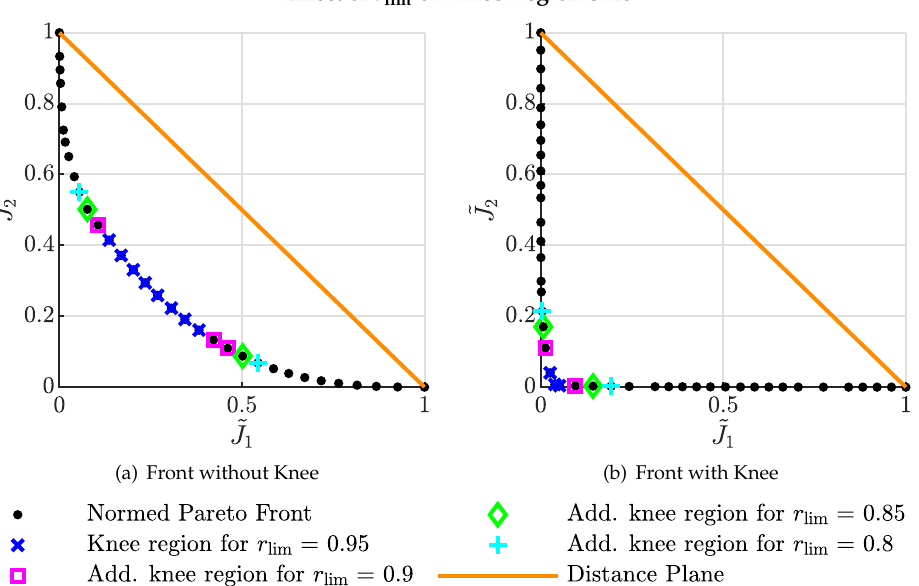
Figure 2. Exemplary knee regions in 2D for different r lim . For fronts without a knee point ( a ), the knee region is larger than for fronts with a knee point ( b ) for any r lim . Note that for convex 2D fronts, the distance plane is equivalent to the convex hull of the minima from [28] (if